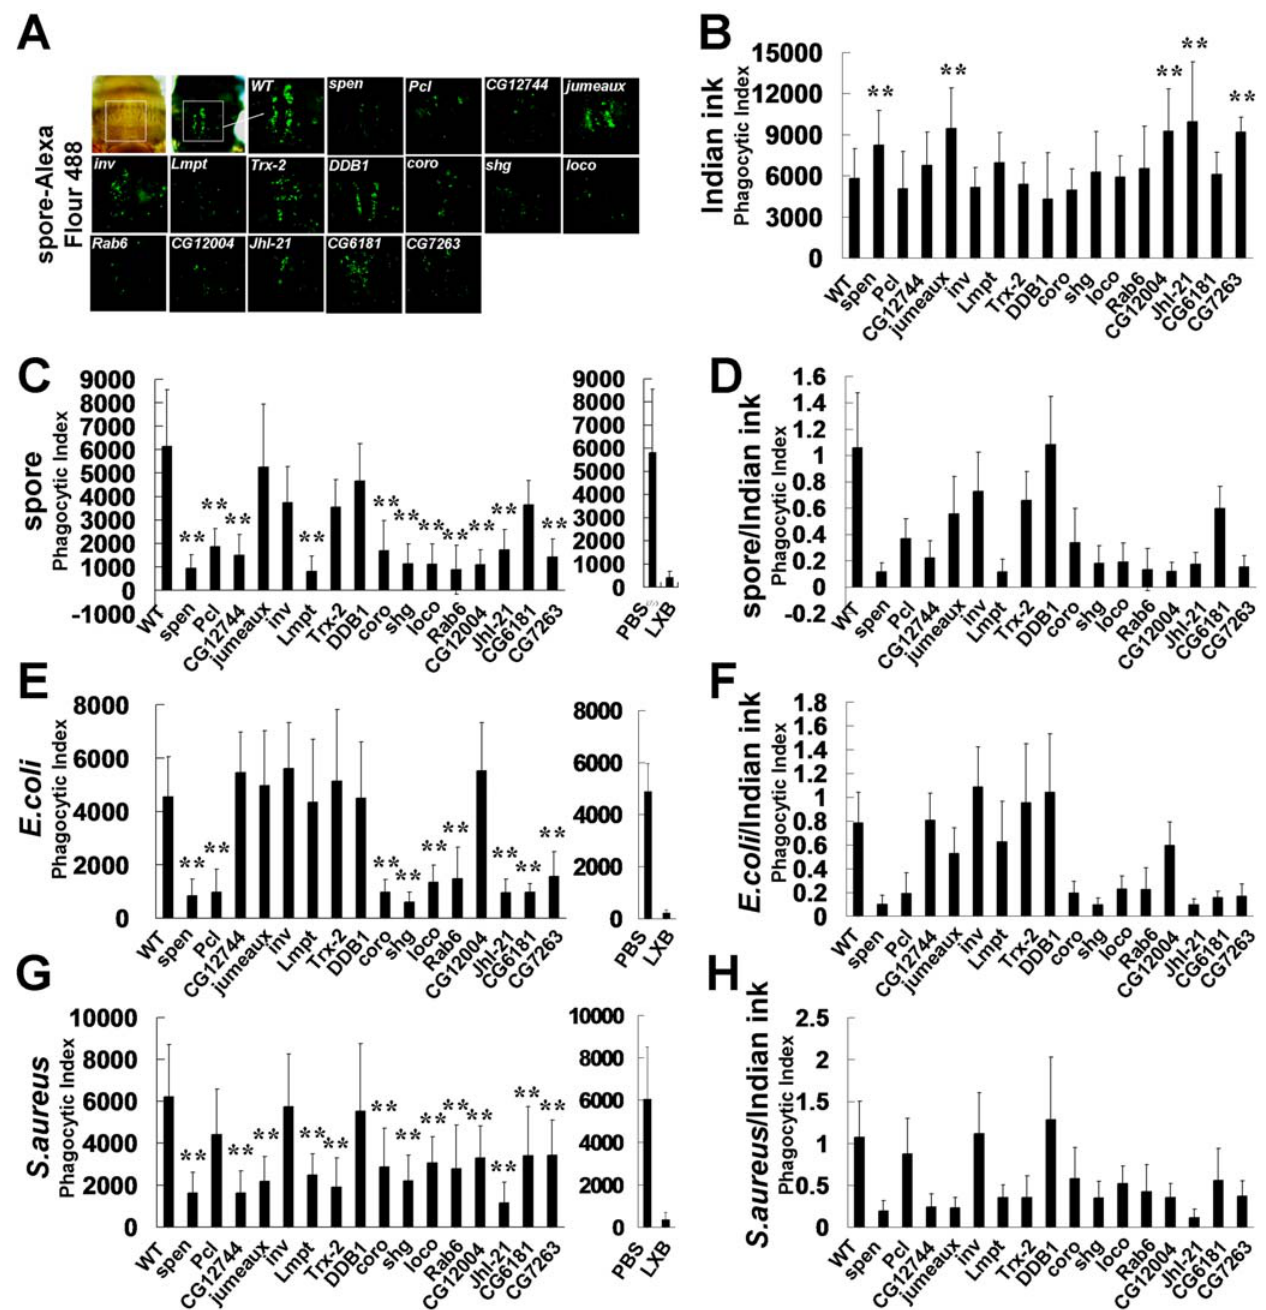
Figure 5. Invivo phagocytosis in adult flies. (A) Adult males of the indicated genotypes were injected with Alexa Fluor 488-labeled heat killed spores of B. bassiana . (B, C, E, G) Quantitation of in vivo phagocytosis of India ink, spore and bacteria. (B) India ink, (C) Alexa Fluor 488-labeled heat killed spores of B. bassiana , (E) Fluorescein conjugated E. coli (K-12), (G) Fluorescein conjugated S. aureus . Phagocytosed signals were observed under a Zeiss Axioplan 2 microscope. Phagocytic index was derived by multiplying the area of the India ink and fluorescence signal measured. Phagocytosis was inhibited by prior injection of latex beads in wild type. LXB, CML latex beads. (D, F, H) A phagocytic index was obtained by multiplying phagocytosing signals with the mean area of internalized India ink. (D) spore, (F) E. coli , (H) S. aureus . The mean and standard deviation of 10–16 adult flies were analyzed for each genotype. p -values were calculated by Student’s t-test. India ink, ** p , 0.1. Fungi and bacteria, ** p , 0.007.